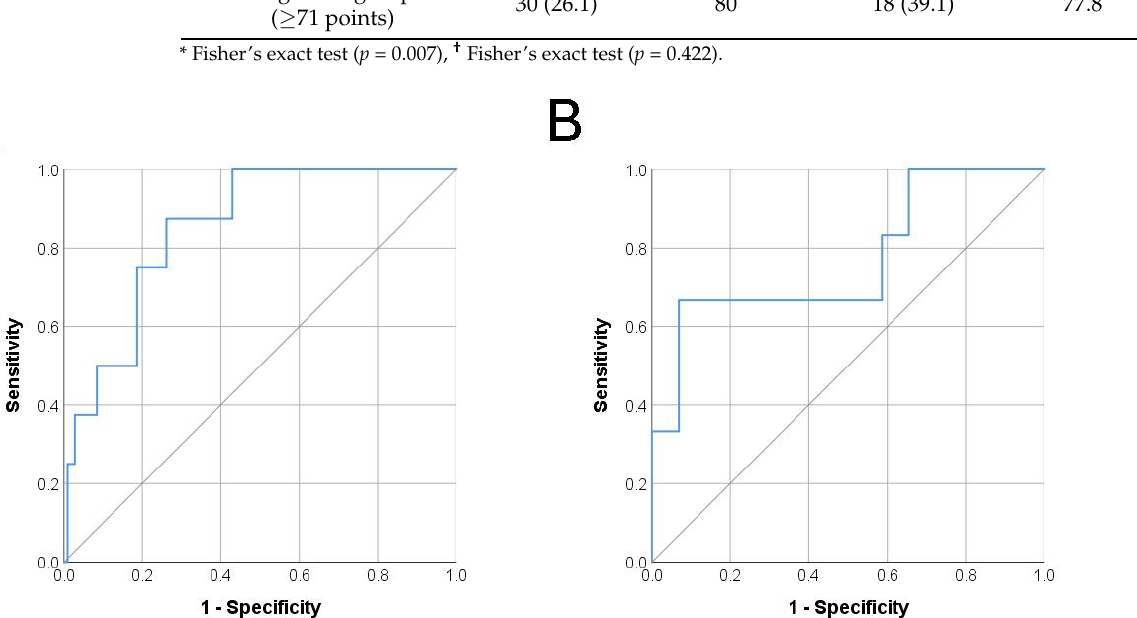
Figure 1. Receiver operating curve analysis of the VUR resolution prediction scoring system for the development cohort ( A ), area under curve = 0.850, 95% CI = 0.744–0.957, p = 0.001) and the validation cohort ( B ), area under curve = 0.770, 95% CI = 0.534–1.000, p = 0.040).